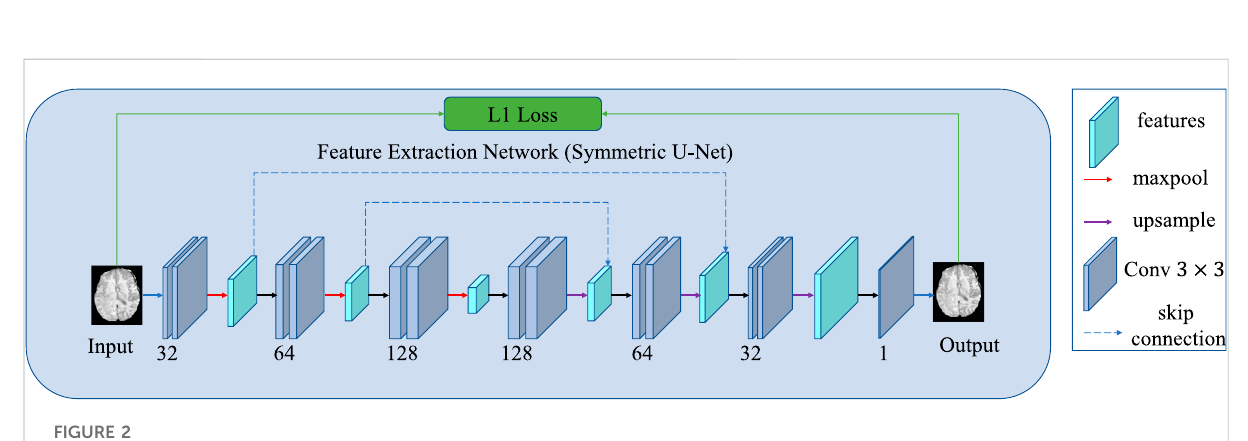
FIGURE 2 Detailed architecture of the feature extraction network, which can be considered as an encoder – decoder with skip